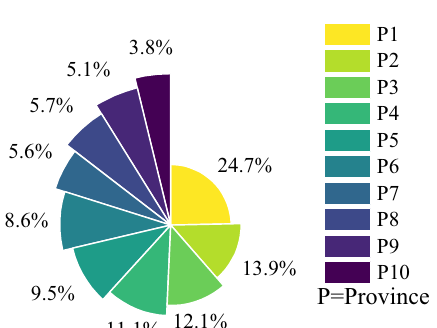
Fig. 7 Top 10 provinces of fault records